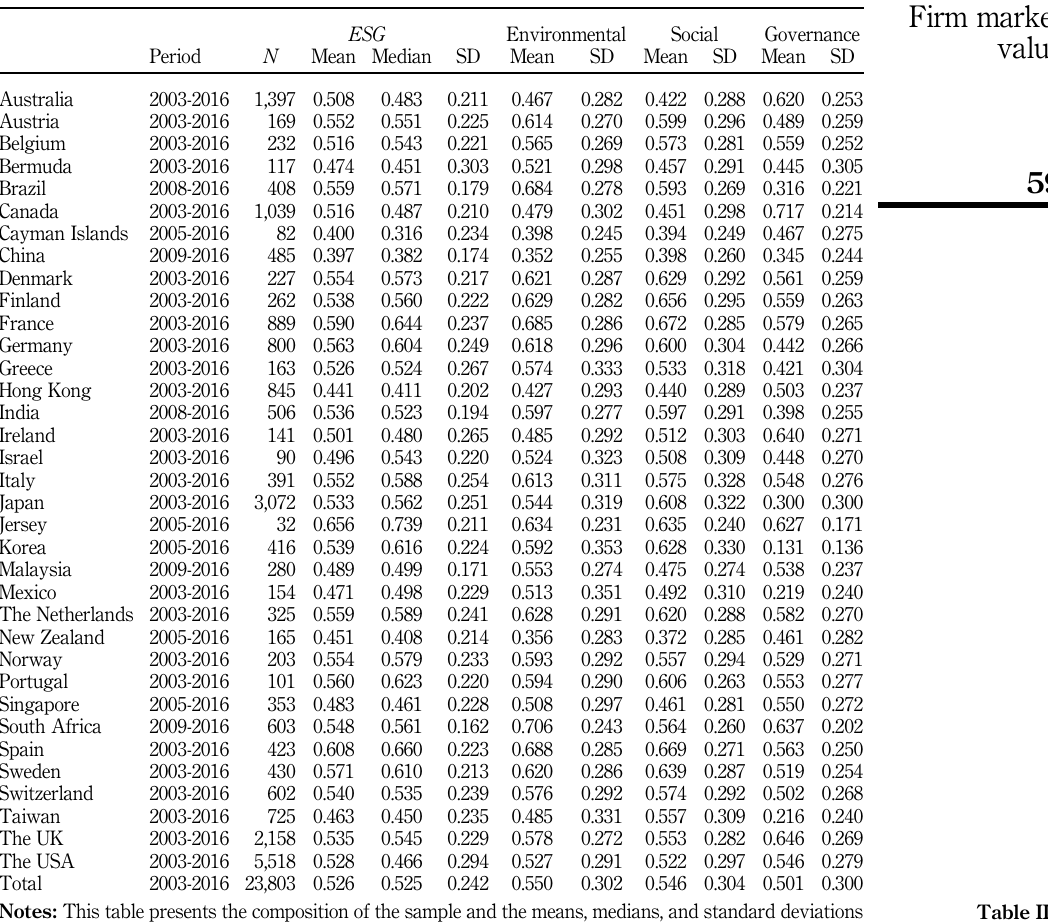
Table III. CSR data by